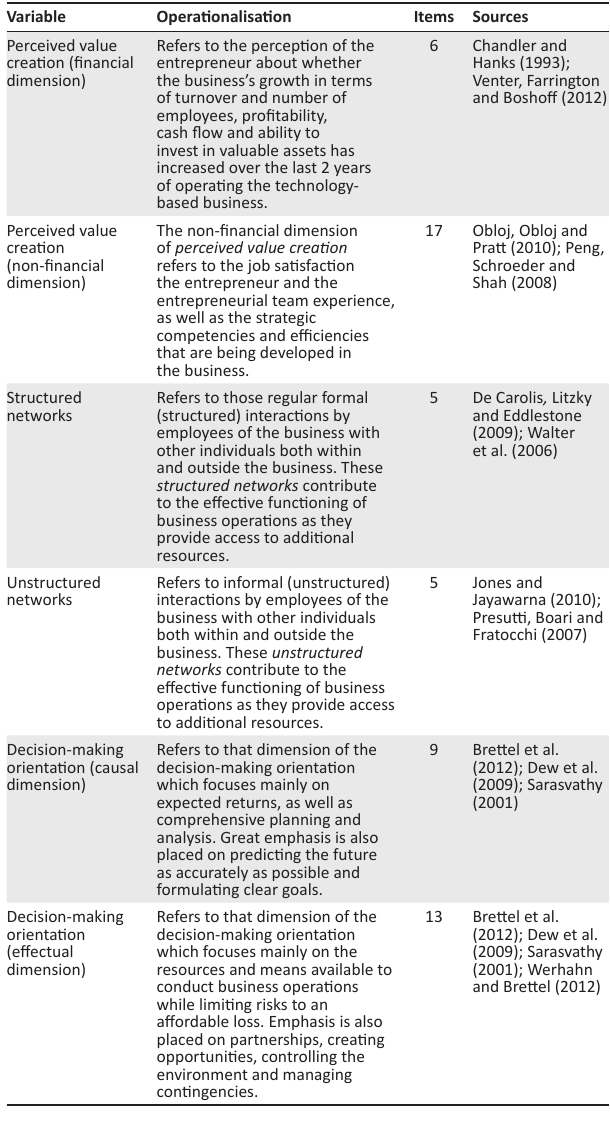
TABLE 1: Scales measuring perceived value creation, structured and unstructured networks and decision-making orientation.